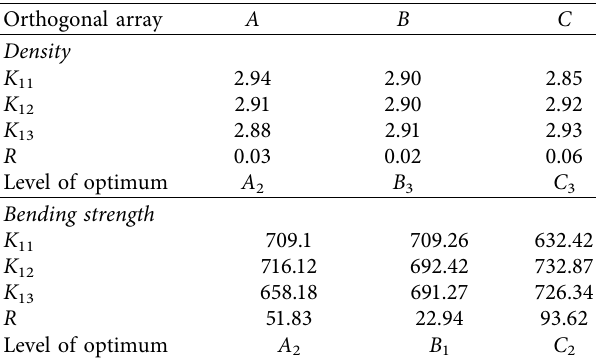
Table 3: Calculation indices of the L 9 orthogonal